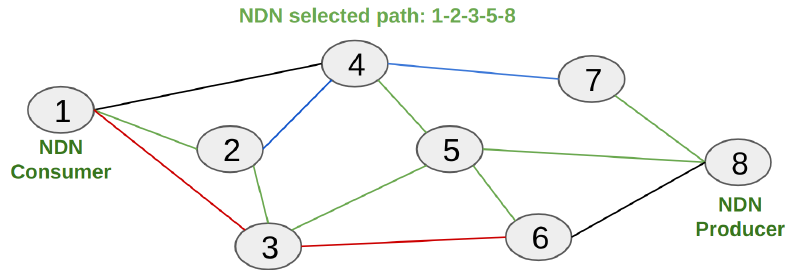
Figure 3. NDN path selection using the proactive